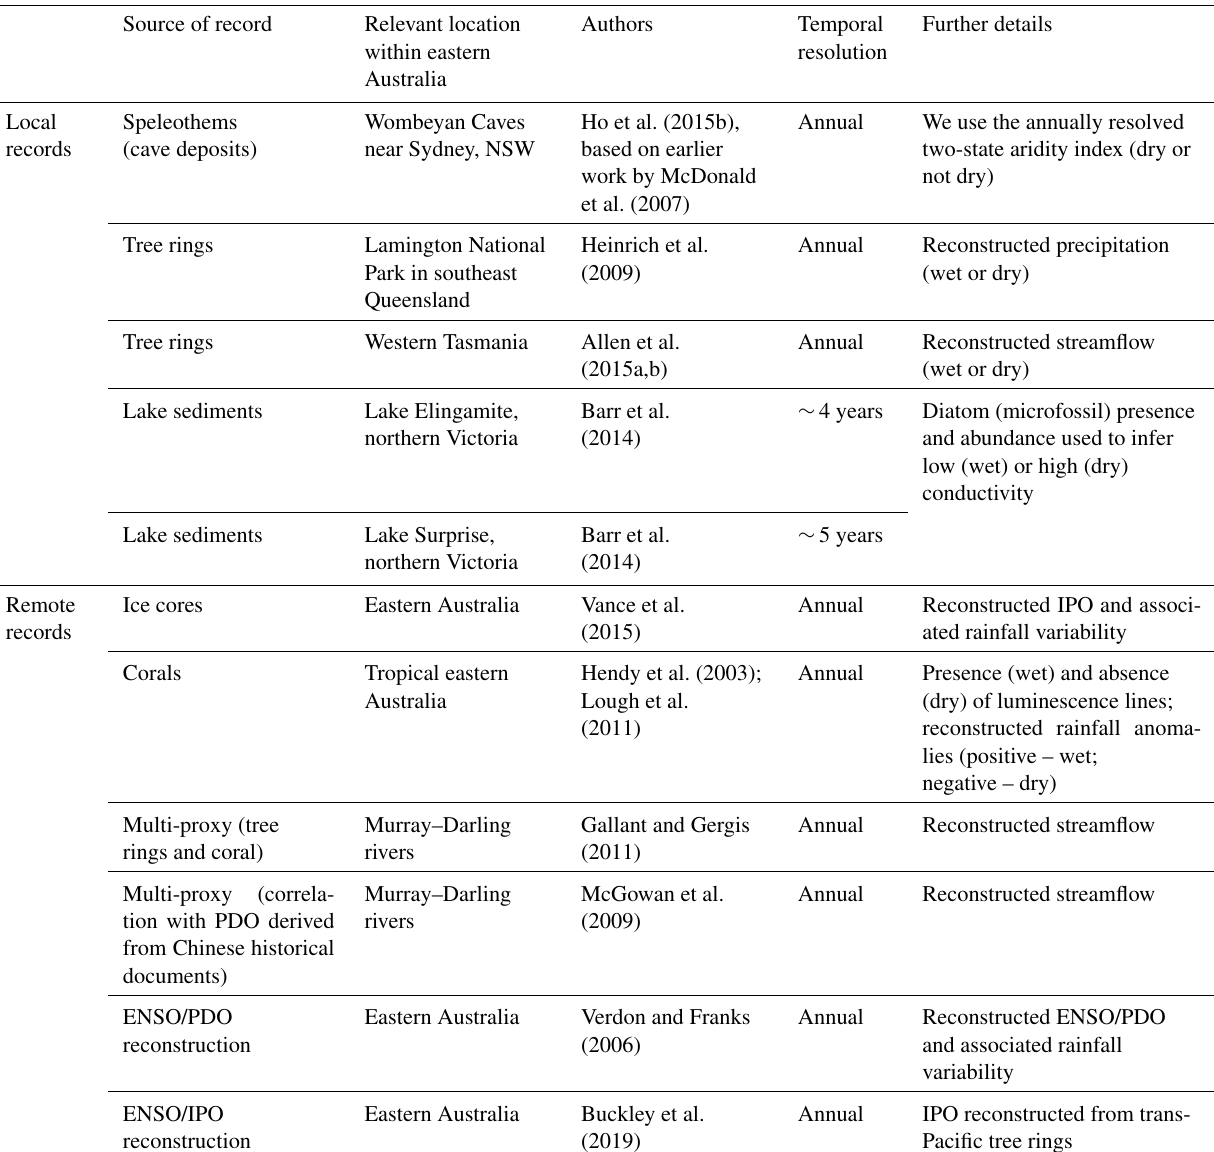
Table 1. Published palaeoclimate records used in this study. Note: El Niño–Southern Oscillation – ENSO; Interdecadal Pacific Oscillation – IPO; Pacific Decadal Oscillation –